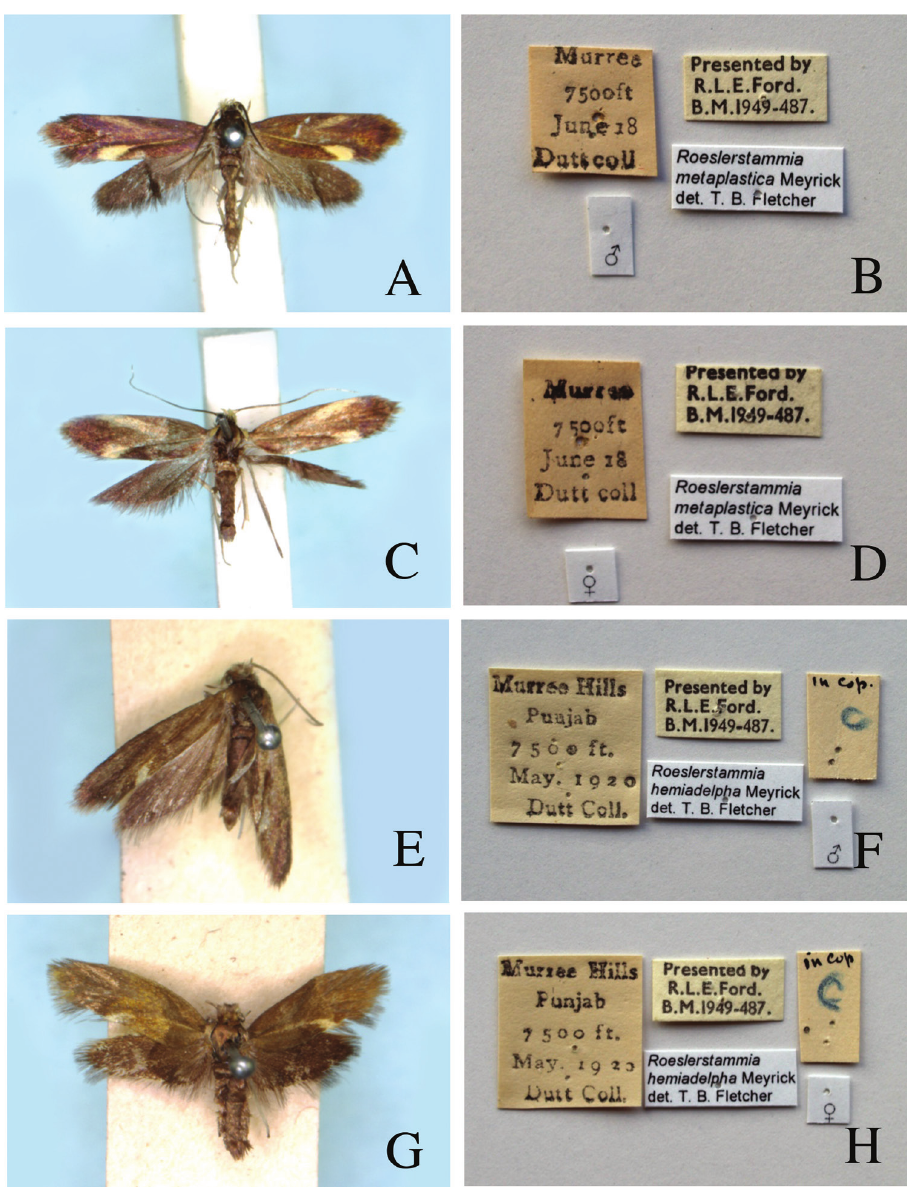
Figure 1. Type series of Roeslerstammia spp. from India. A Lectotype of R. metaplastica Meyrick, 1921, male B Ditto , labels C Paralectotype of R. metaplastica Meyrick, 1921, female D Ditto , labels E Lectotype of R. hemidelpha Meyrick, 1922, male F Ditto , labels G Paralectotype of R. hemidelpha Meyrick, 1922, female H Ditto ,